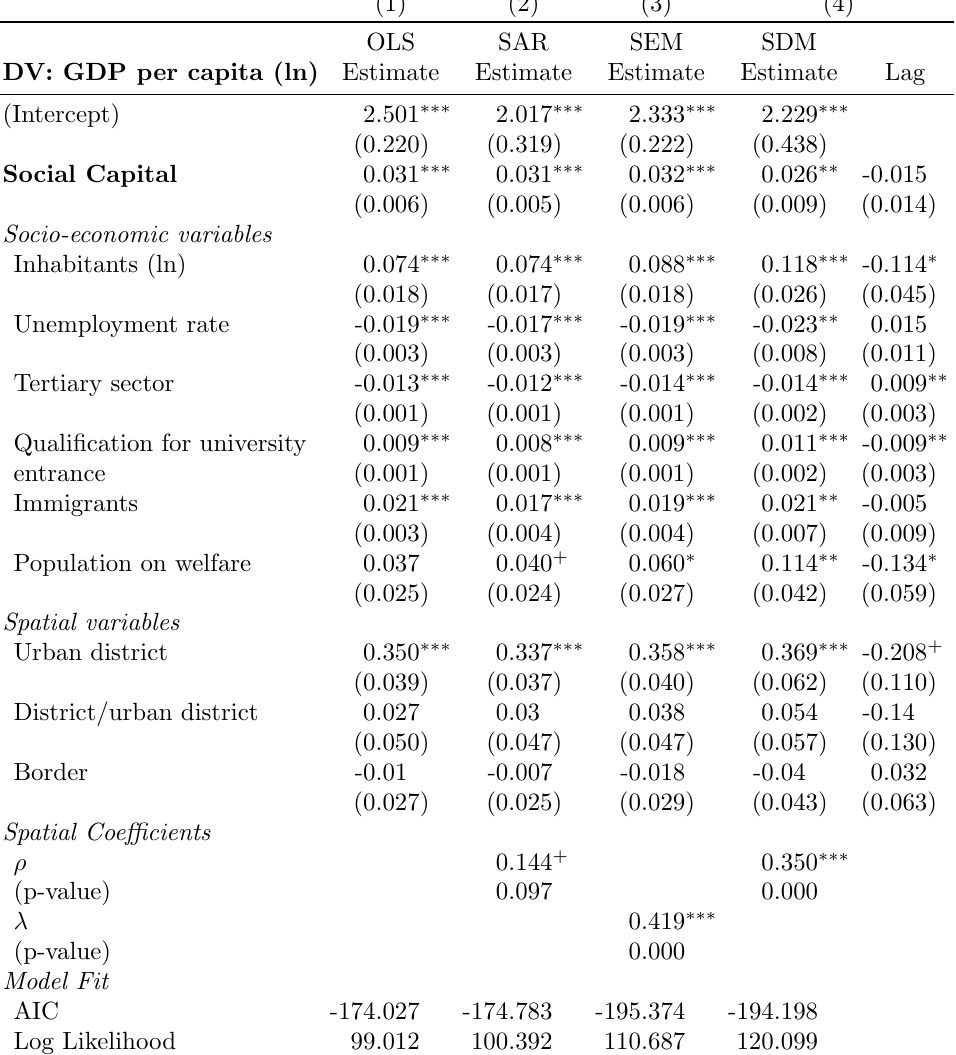
Table 1: Explaining regional differences in economic well-being using spatial regression